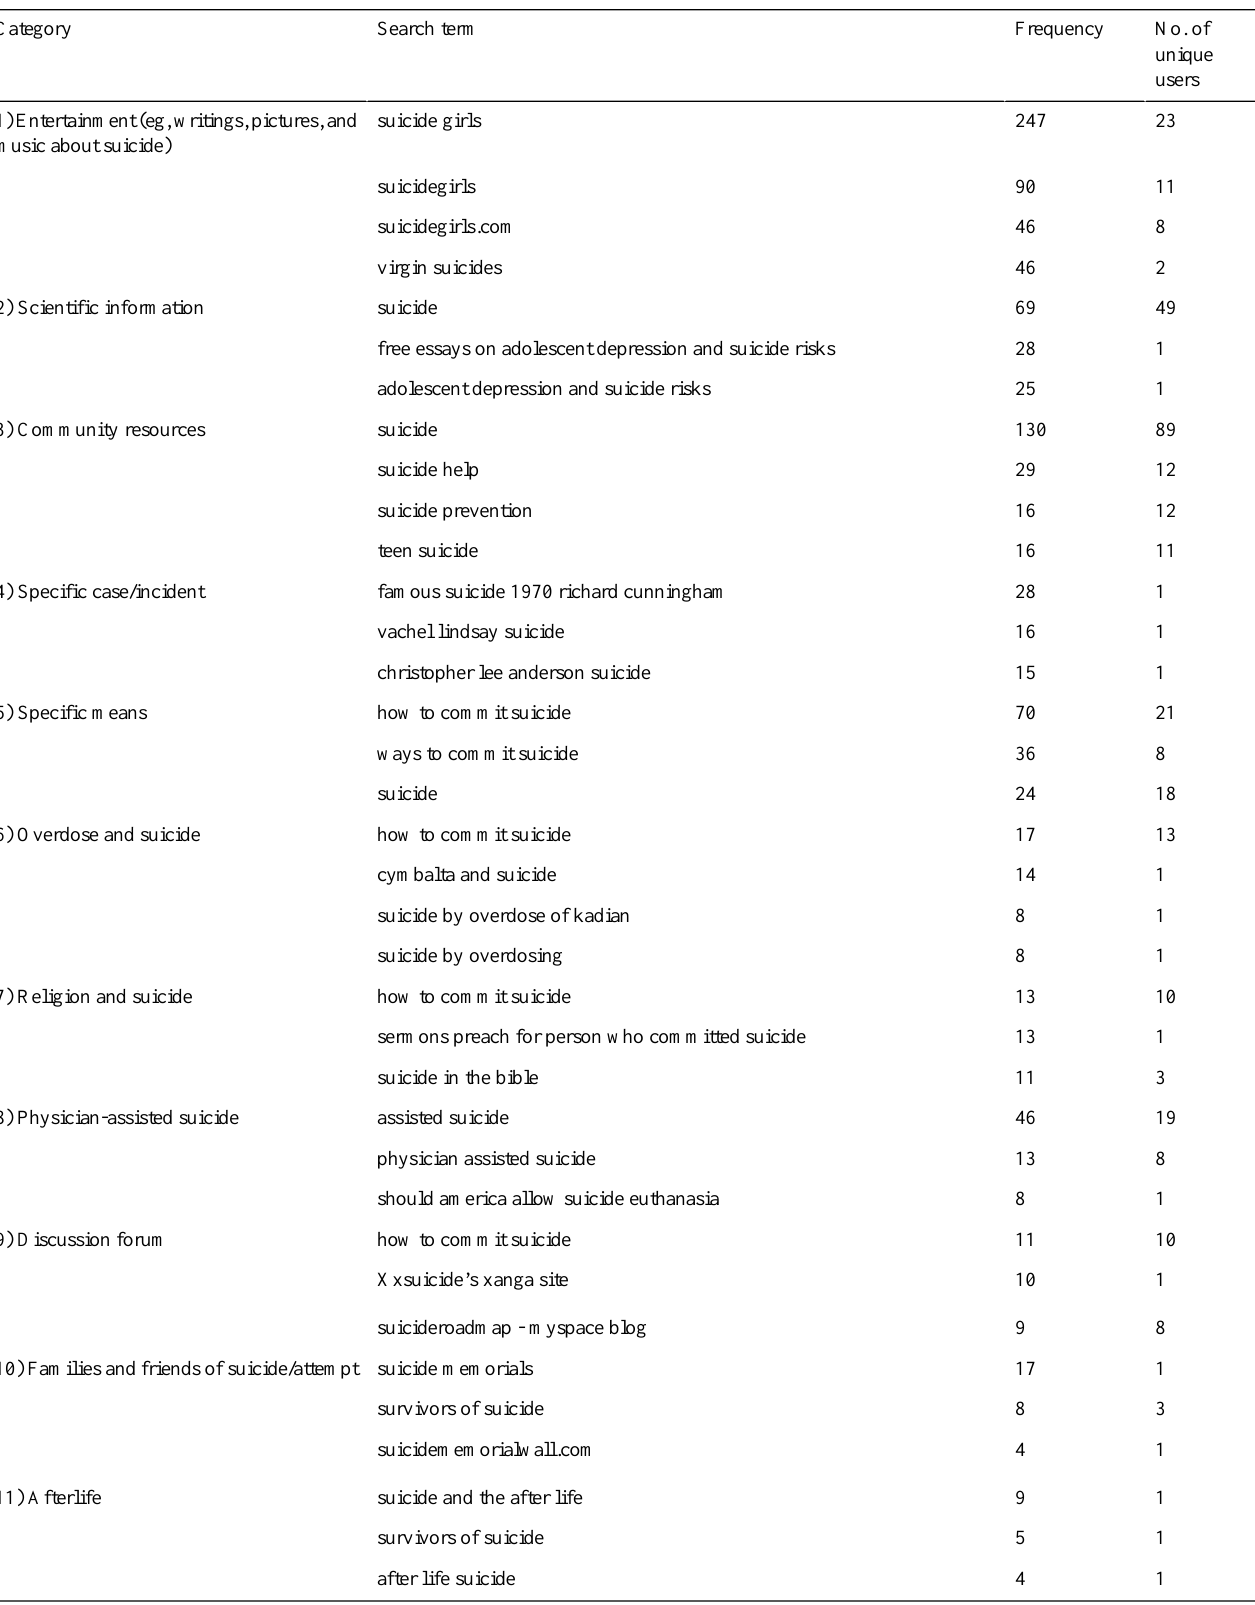
Table 1. Top three search terms and their search frequencies in each category.